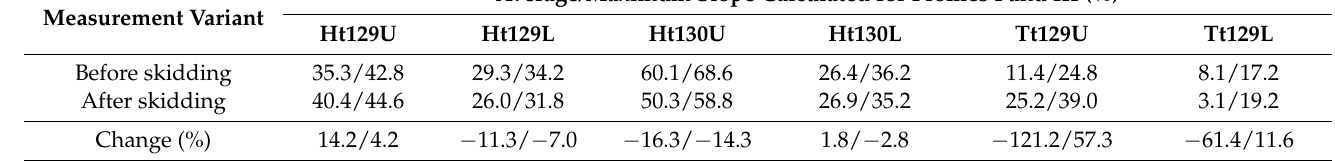
Table 5. Average and maximum ground slope in the central 1.5-m-wide section of the trail before (T1) and after timber skidding (T2).